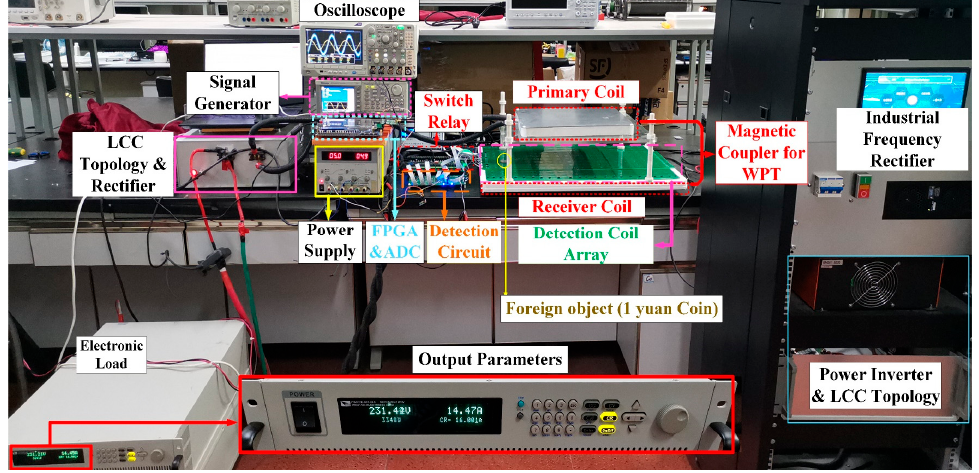
Figure 15. FOD experimental prototype based on the 3.3 kW wireless power transfer system. The detection results are shown in Figures 16–18.